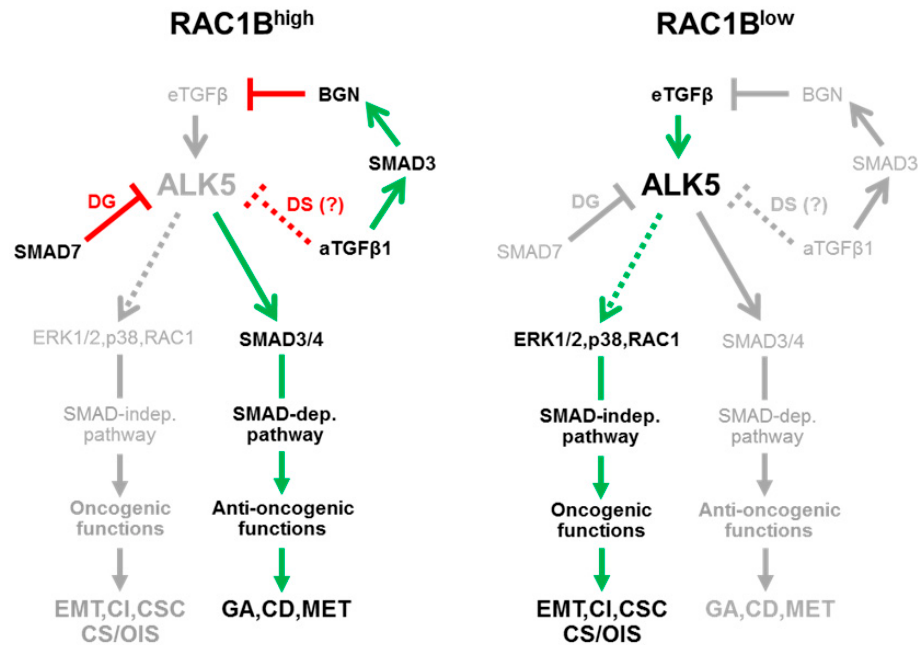
Figure 4. Schematic diagram illustrating the proposed role of RAC1B in regulating TGF β signaling in pancreatic tumor cells. Left-hand side, RAC1B inhibits receptor activation via (i) induction of SMAD7 and SMAD7-mediated degradation (DG) of ALK5, (ii) autocrine TGF β (aTGF β )-mediated desensitization (DS) of cells towards exogenous TGF β , and (iii) aTGF β -SMAD3-mediated induction of BGN, which sequesters exogenous TGF β (eTGF β ) in the pericellular space and prevents it from binding to the receptors. As a result, the activities of the Smad3 / 4 and non-Smad (ERK1 / 2, p38, RAC1) signaling pathways are repressed, but the decrease in Smad signaling is partially rescued by RAC1B-driven upregulation of SMAD3 and SMAD4 (not shown). This constellation suppresses oncogenic programs like EMT, cell invasion (CI), and cancer stem cell (CSC) formation, but allowing tumor-suppressive functions such as growth arrest (GA), cell death / apoptosis (CD), and mesenchymal–epithelial transition (MET) to proceed. Right-hand side, under conditions of low or absent RAC1B expression, ALK5 expression is increased and subsequent activation of non-canonical signaling predominates over Smad signaling, an e ff ect that is enhanced by the inability of the cell to produce additional SMAD3 and SMAD4 proteins. Non-canonical TGF β signaling pathways, in particular ERK and RAC1, can now promote their oncogenic functions. Cellular senescence (CS) and oncogene-induced senescence (OIS), although driven by MEK-ERK signaling [92–94], are generally considered tumor-suppressive mechanisms but may also be tumor-promoting in some instances [112]. Stimulatory interactions are indicated by arrows and inhibitory interactions by lines (green / red = activated, gray-shaded = inactivated). Stippled lines denote still hypothetical interactions (aTGF β ) or the possibility of ALK5-independent activation (ERK1/2, RAC1).